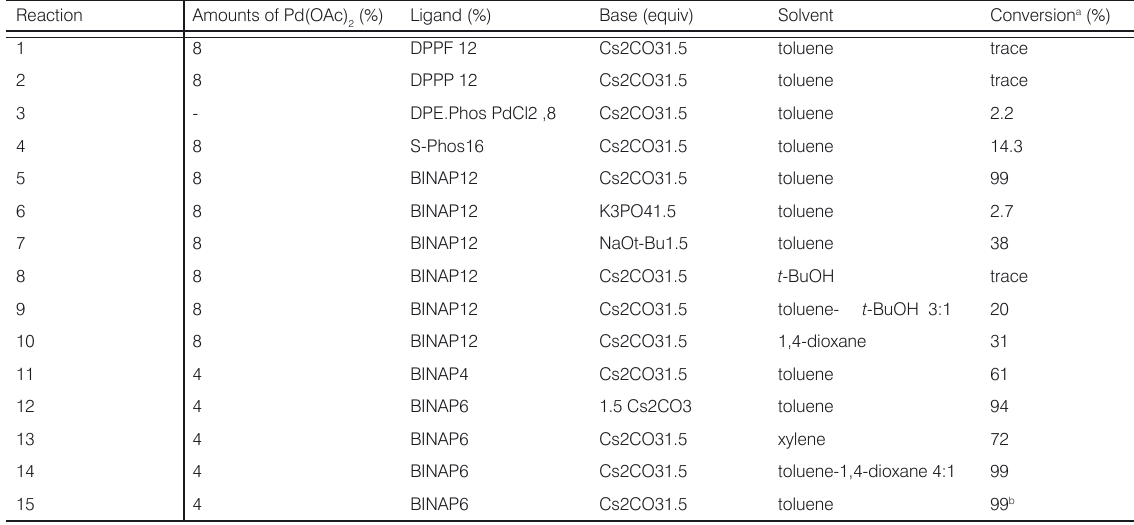
Table 1. A summary of the reactions of quinaldine-5-triflate ( 1 ) with piperidine ( 2b